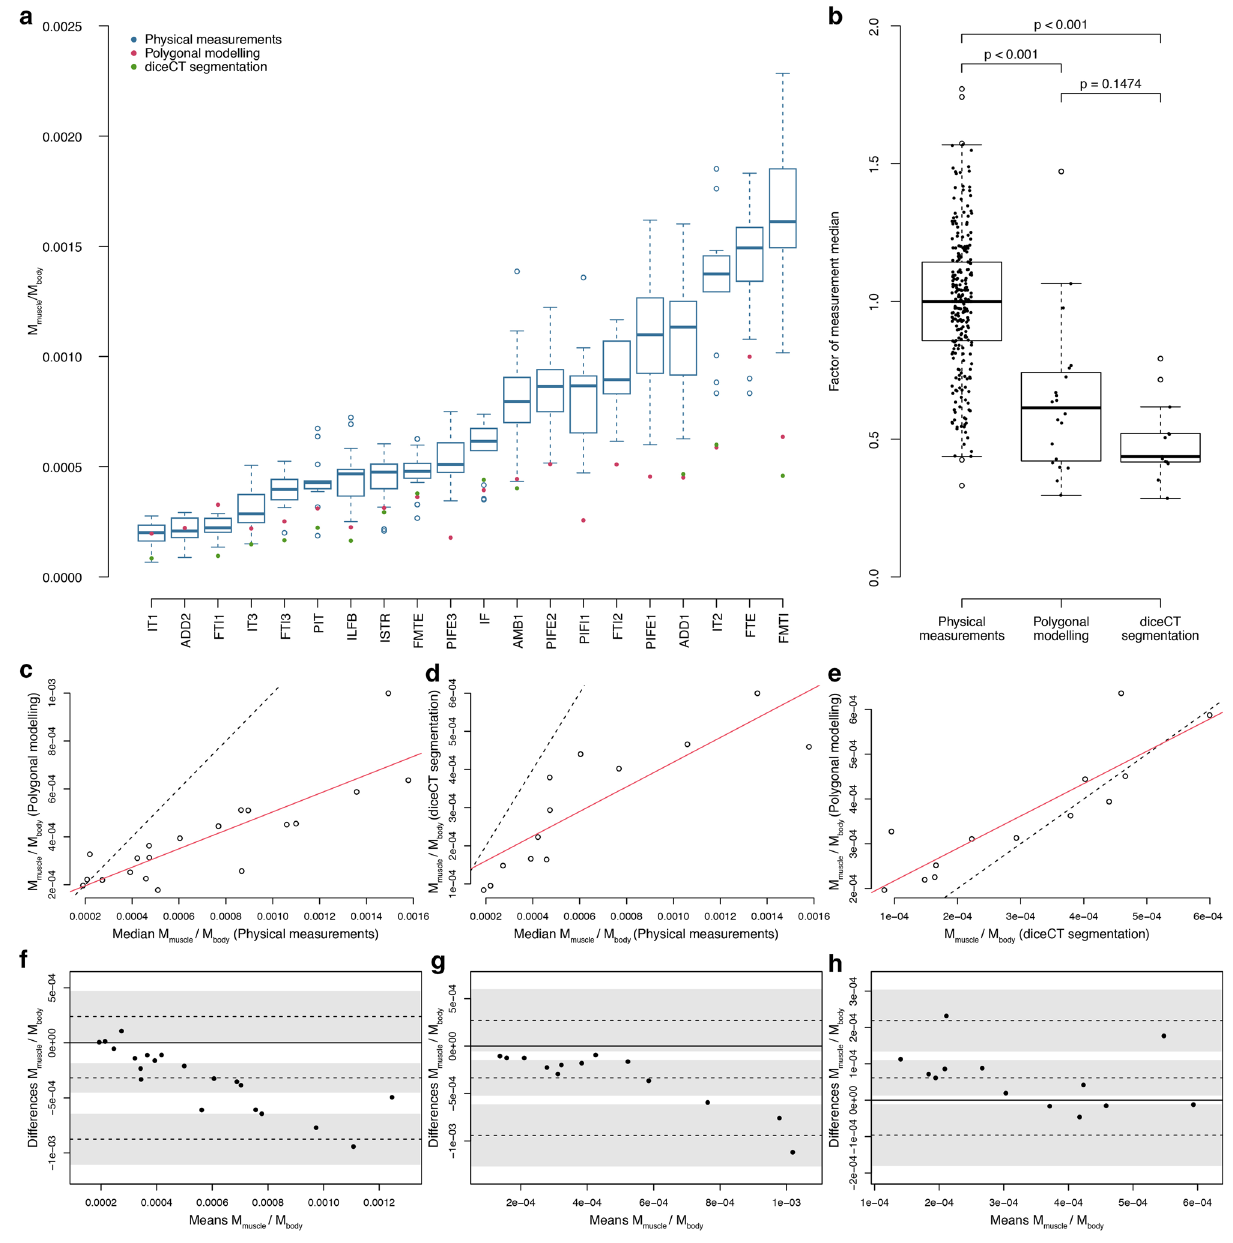
Figure 2. Evaluation of muscle mass estimates for the Nile crocodile. Comparison between individual muscles’ measurements and 3D reconstructions ( a ), ordered according to relative muscle mass (M muscle /M body = muscle mass normalised by body mass). Boxplots of the physical (dissection-based) measurements in blue, muscle volume estimates from the polygonal modelling in red and calculation from diceCT segmentation in green. Note only 13 out of 20 muscles could be unequivocally segmented, hence some are missing; see Table 2 and Supplementary Information. Boxplots of the different 3D reconstructions and physical measurements ( b ). The individual muscle masses were normalised by the median of the physical measurements for each respective muscle. This shows that physical measurements of mass or volume tended to be greater than polygonal modelling and diceCT segmentation, which themselves did not significantly differ. Comparison between physical measurements and polygonal modelling ( c ) and Bland–Altman plot of the same comparison ( f ); bias -0.000318 ± 0.000133. Line of equality in ( c ) is in dashed black and linear regression model in red (y = 0.385365 x + 0. 0.000119; adjusted R 2 = 0.6977). Comparison between physical measurements and diceCT segmentation ( d ) and Bland–Altman plot of the same comparison ( g ); bias -0.000335 ± 0.000187. Line of equality in ( d ) is in dashed black and linear regression model in red (y = 0.323222 x + 0.000096; adjusted R 2 = 0.6967). Comparison between diceCT segmentation and polygonal modelling ( e ) and Bland–Altman plot of the same comparison ( h ); bias 0.000062 ± 0.000049). Line of equality in ( e ) is in dashed black and linear regression model in red (y = 0.723366 x + 0.000145; adjusted R 2 =